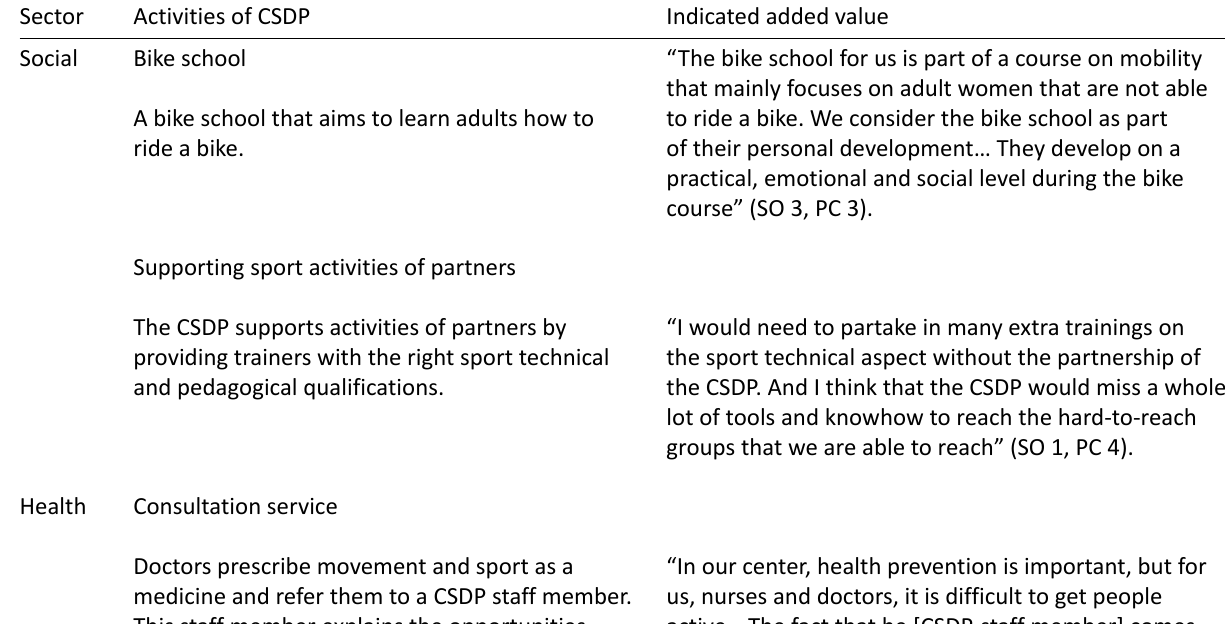
Table 2. Indicated added value of activities of the CSDP for social, health, cultural and youth